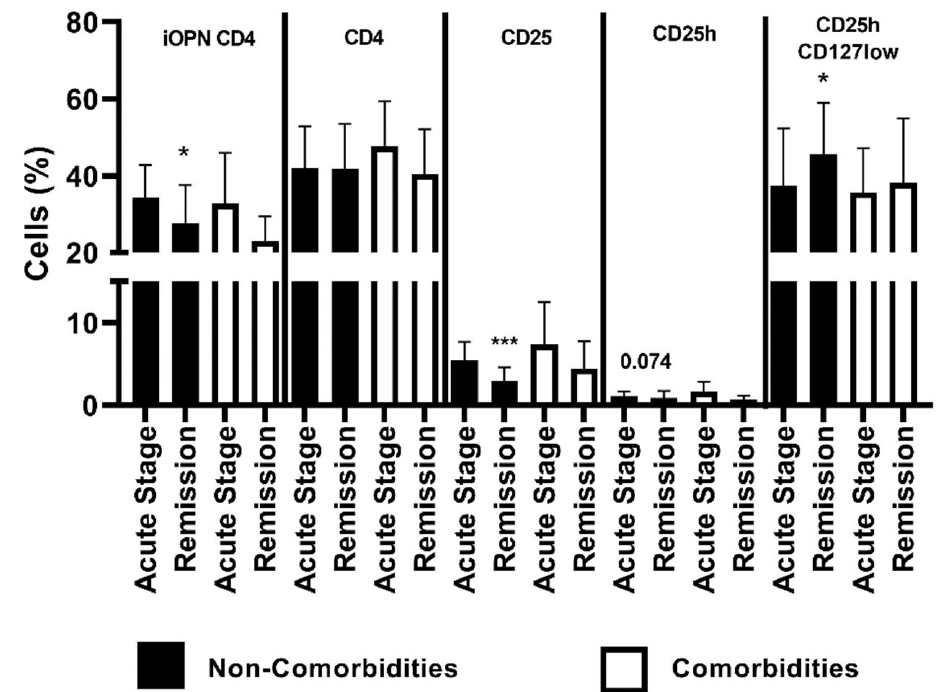
Figure 4. The percentage of examined populations of CD4+ T lymphocytes depending on the presence of comorbidities. iOPN CD4, CD4 T lymphocytes with expression of intracellular osteopontin; CD4, CD4 positive T lymphocytes; CD25, subset of CD4 positive T lymphocytes; CD25h, CD25 high T lymphocytes; CD25hCD127low, CD25highCD127low T cells—regulatory T cells; NS, non-significant; * means statistical significance with p values < 0.05 between patients with acute stage of ACD and with remission; *** means statistical significance with p < 0.0001 between patients with acute stage of ACD and with remission.